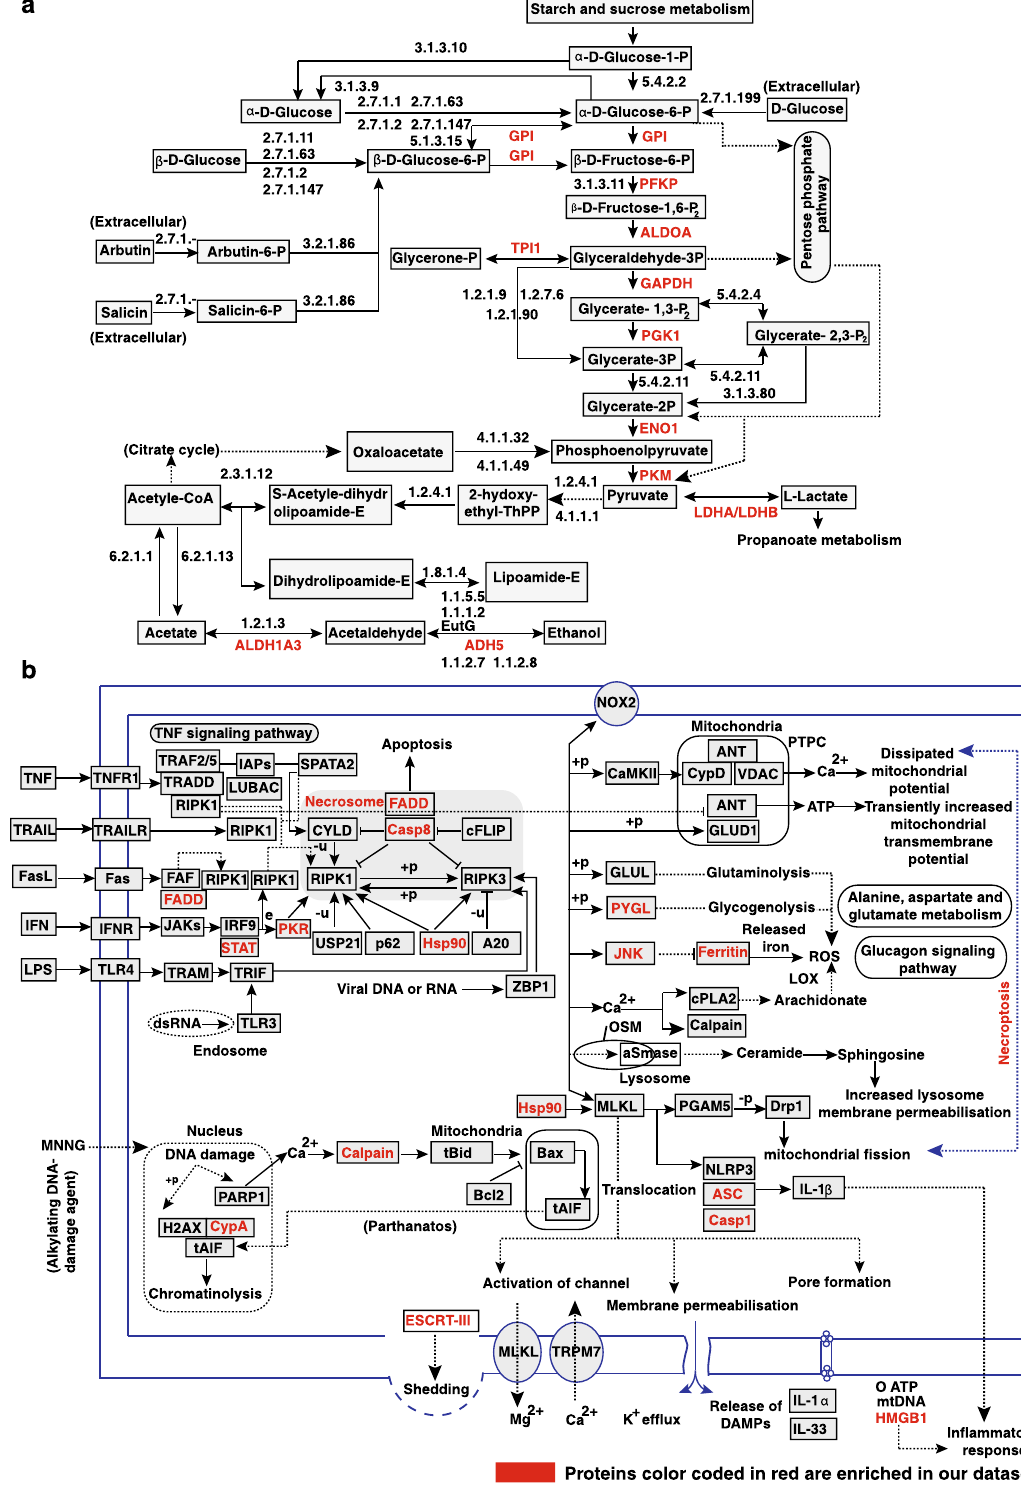
Figure 3. Chronic shammah treatment alters necroptosis pathway. Kyoto Encyclopedia of Genes and Genomes (KEGG) 80 pathway analysis of downregulated and/or hypophosphorylated proteins ( a ) downregulated and/or hypophosphorylated proteins showed enrichment of metabolic pathway glycolysis and ( b ) necroptotic pathway. Proteins color coded in red are enriched in our